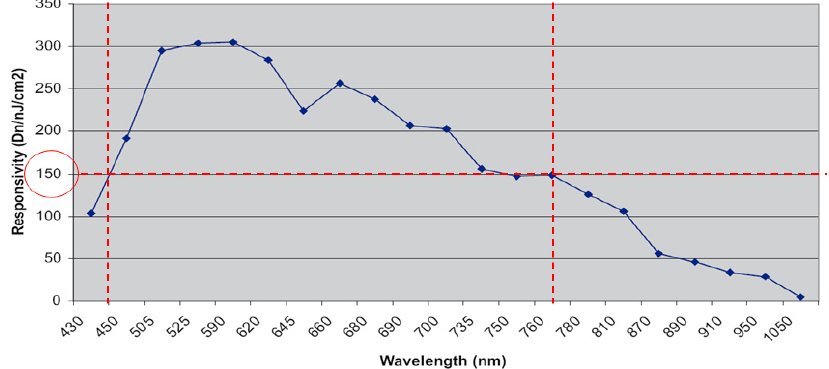
Figure 4. The responsibility of the TDI-CCD (time delay and integration-charge couple device) illustrates spectral distribution.